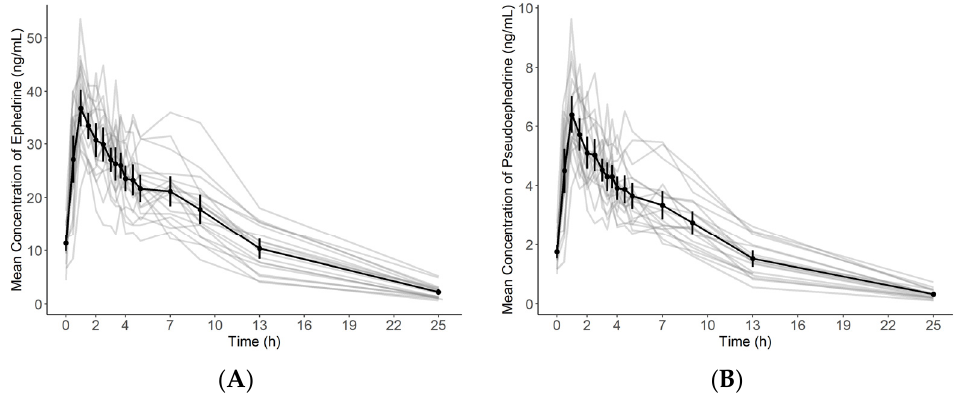
Figure 3. Mean (±standard deviation) plasma concentration-time profile of ephedrine and Figure 3. Mean ( ± standard deviation) plasma concentration-time profile of ephedrine and pseu- pseudoephedrine in the plasma samples of 20 healthy volunteers after the oral administration of doephedrine in the plasma samples of 20 healthy volunteers after the oral administration of OJS OJS powder overlaid on gray individual spaghetti plots: ( A ) Ephedrine; ( B ) Pseudoephedrine. powder overlaid on gray individual spaghetti plots: ( A ) Ephedrine; ( B ) Pseudoephedrine. The concentrations of ephedrine from 8 subjects and pseudoephedrine from all sub- Table 4. Pharmacokinetic parameter estimates of ephedrine and pseudoephedrine after the oral jects were below the LLOQ at 49 h after the last OJS dose. In contrast, all concentrations administration of OJS powder. ( n = 20). of both components were detectable at 25 h. Thus, 25 h was used as the last concentration time to calculate the AUC last . Additionally, the mean ± SD of AUC last of ephedrine, includ- ing 49 h, was 353.78 ± 101.42; this value did not considerably differ from the AUC last of ephedrine, excluding 49 h (336.88 ng·h/mL).